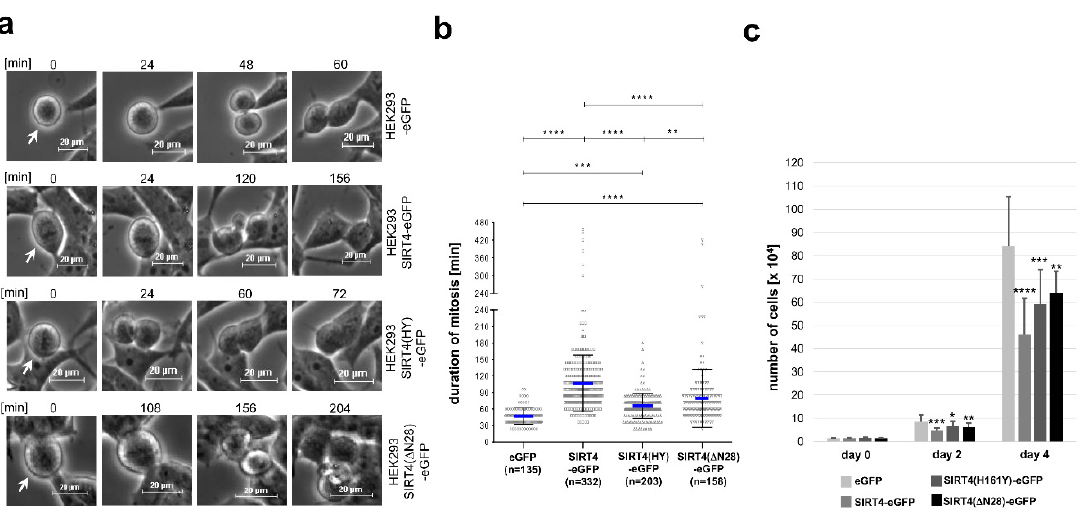
Figure 4. Ectopic expression of SIRT4 prolongs mitotic progression and inhibits cell proliferation. ( a ) HEK293 cell lines stably expressing SIRT4-eGFP, the enzymatically inactive mutant SIRT4(H161Y)- eGFP, or SIRT4( ∆ N28)-eGFP lacking the N-terminal mitochondrial targeting signal were analyzed by live cell imaging. Cell lines were cultured in CO 2 -independent, HEPES containing media. Pictures of cells undergoing cell division were taken in intervals of 12 min. ( b ) Duration of mitosis was calculated from cell rounding / early mitosis to cytokinesis / cell reattachment. To evaluate statistical significance one-way ANOVA followed-up by Tukey’s test was performed (** p < 0.01; *** p < 0.001; **** p < 0.0001). ( c ) Proliferation kinetics of HEK293 cells expressing SIRT4-eGFP or the indicated SIRT4 mutants. Cells were seeded at day 0 (15,000 cells / well) in triplicates and total cell numbers were counted at the indicated time points ( n = 3–5 independent experiments). To evaluate statistical significance one-way ANOVA followed-up by Tukey’s test was performed (* p < 0.05; ** p < 0.01; *** p < 0.001; **** p < 0.0001).